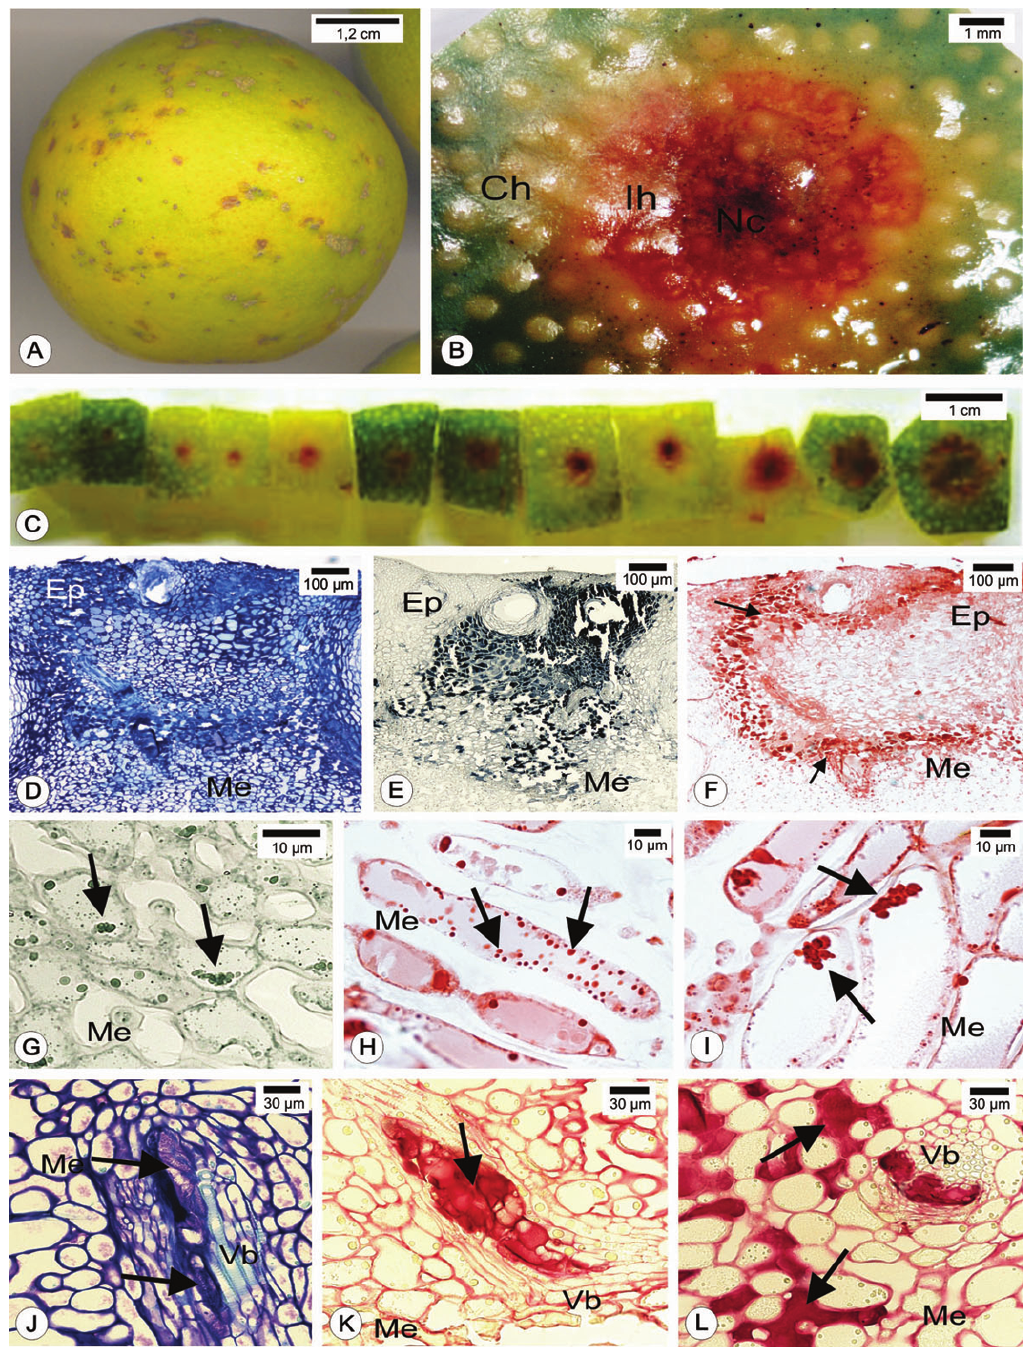
Fig. 3 – Fruit lesions caused by CiLV-N in Citrus sinensis (L.) Osbeck ‘Pêra’. Sections stained with Ruthenium Red (K,L), Sudan Black B (E,G), Toluidine Blue (D,J) and Xylidine Ponceau (F,H,I). A. Overview of injured fruit. B. Typical lesion. Nc – necrotic center; Ih - intermediate halo; Ch – chlorotic halo. C. Possible evolution stages of the fruit lesions caused by CiLV-N. D-L. Cross sections of the lesion indicated in B. E an G. Cells with lipid content in the necrotic center (D) and lipid dropless (E) in the outer halo (arrows). F, H-I. Protein droplets within the cells. J-L. Traumatic gum duct (arrow) along the vascular bundle. L. Pectic substances in the intercellular spaces (arrows). Ep – Epicarp; Me – Mesocarp; Vb – Vascular